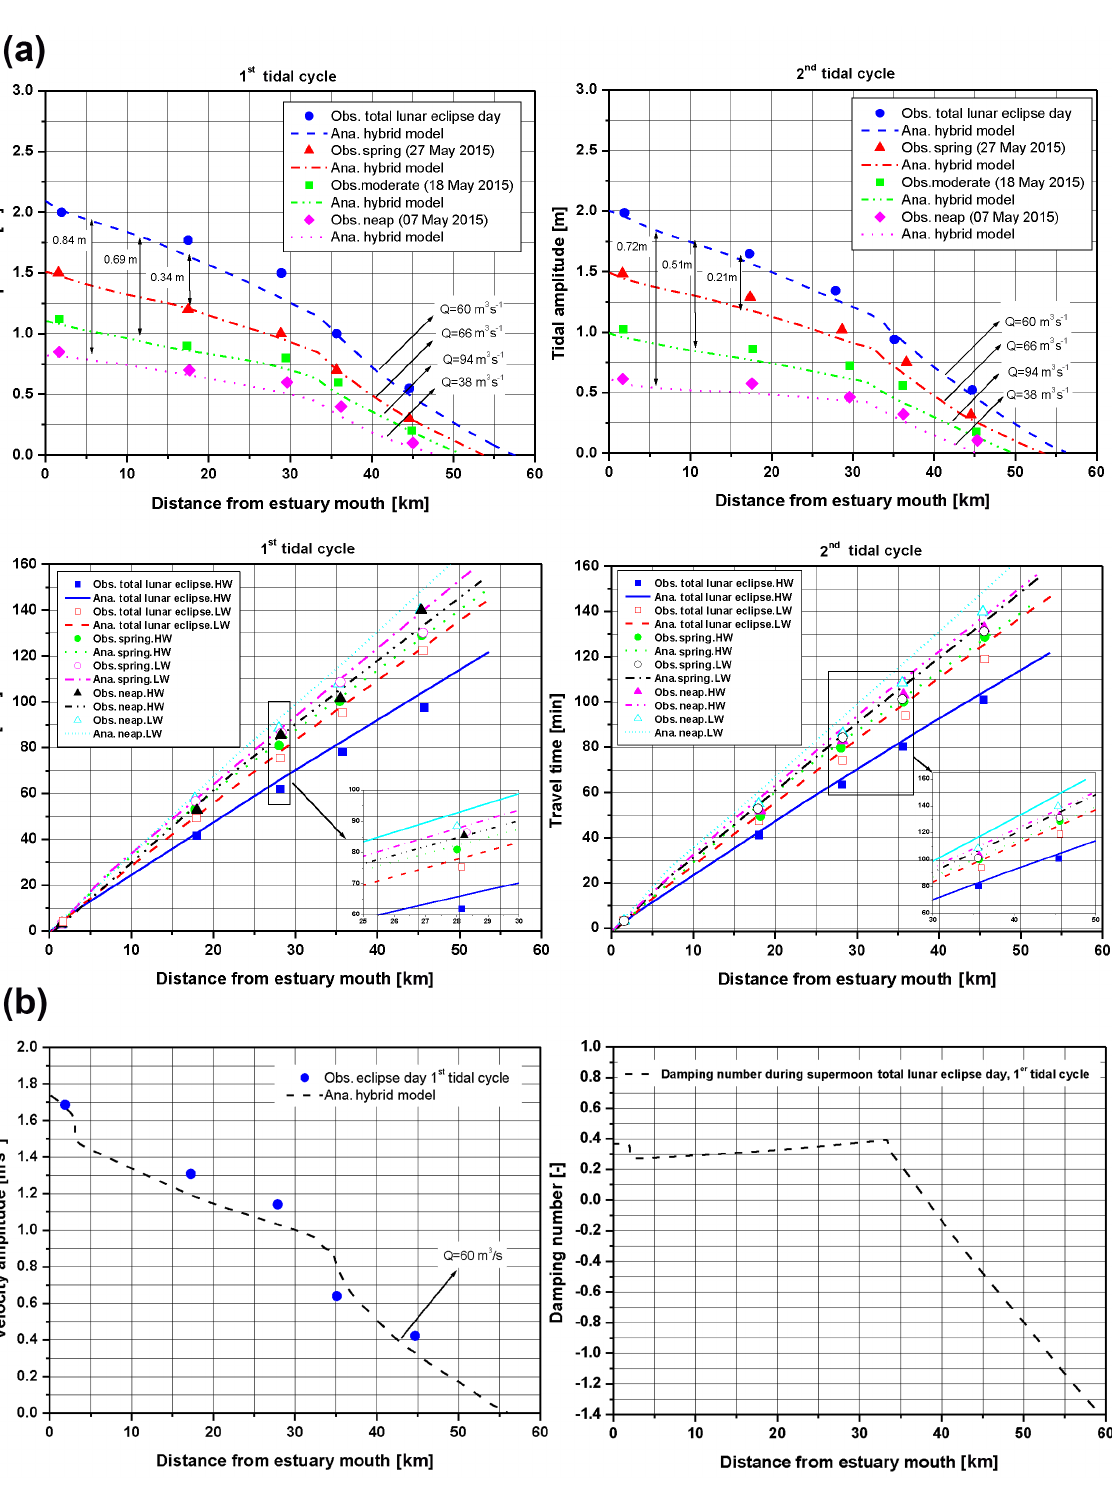
Figure 9. (a) Analytically computed tidal amplitude and traveling time along the Sebou estuary at supermoon total lunar eclipse day. (b) Analytically computed velocity amplitude and damping number along the Sebou estuary at supermoon total lunar eclipse day.